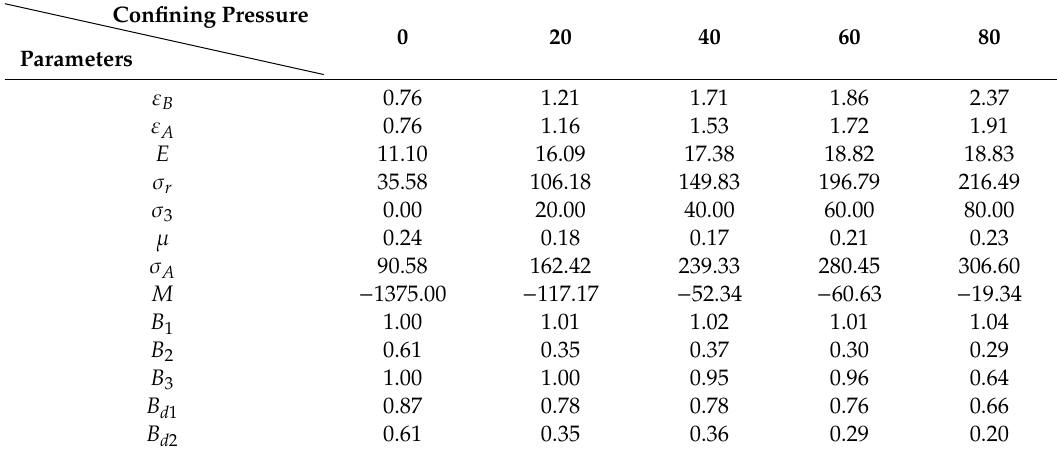
Table 3. Table of detailed parameters of shale sample